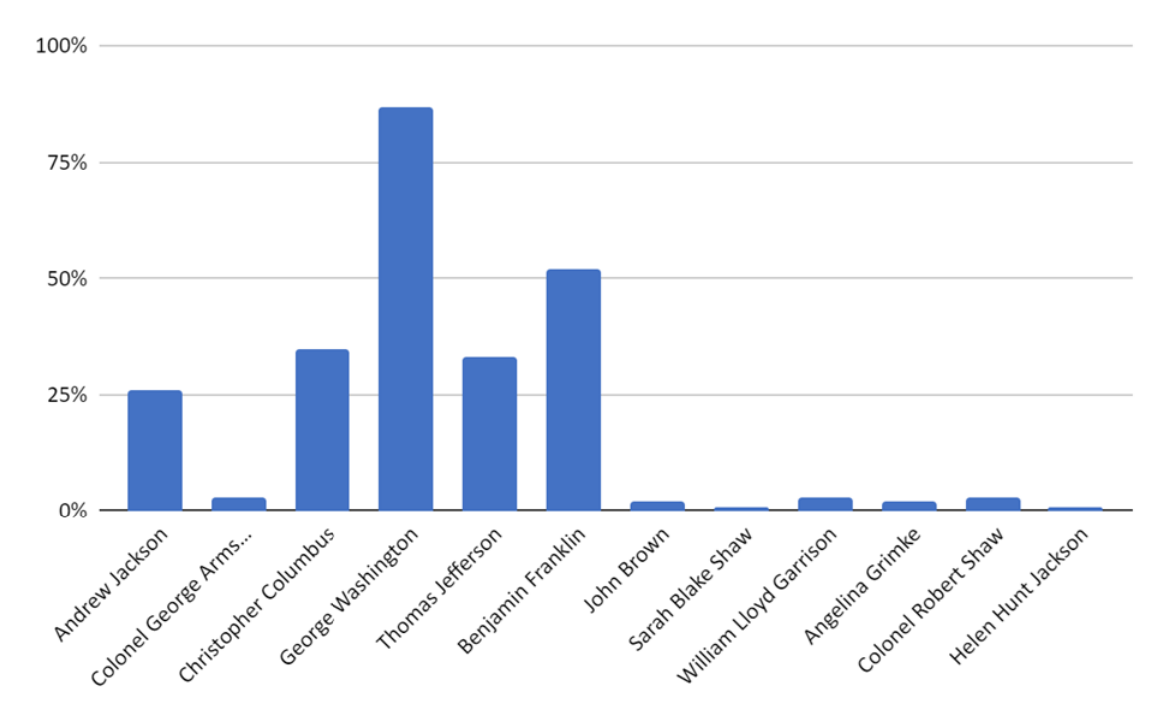
Table 1: Ability to Identify Historical Figures by